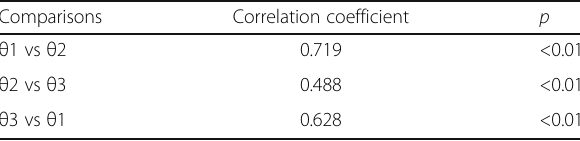
Table 2 Statistical analysis of angular measurements θ 1, θ 2, and θ